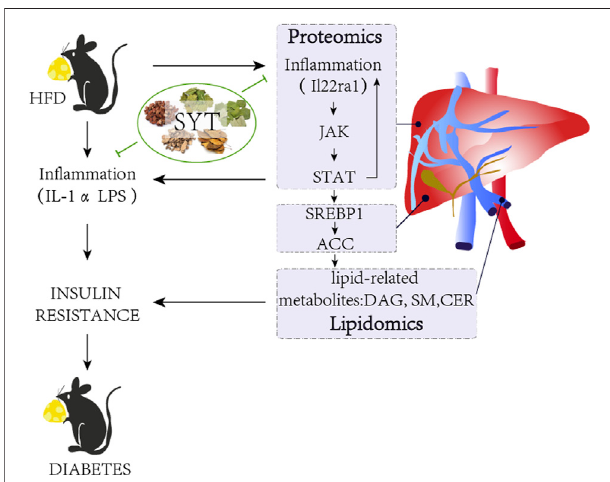
FIGURE 8 | Schematic diagram describing the mechanism of SYT on HFD-induced obesity